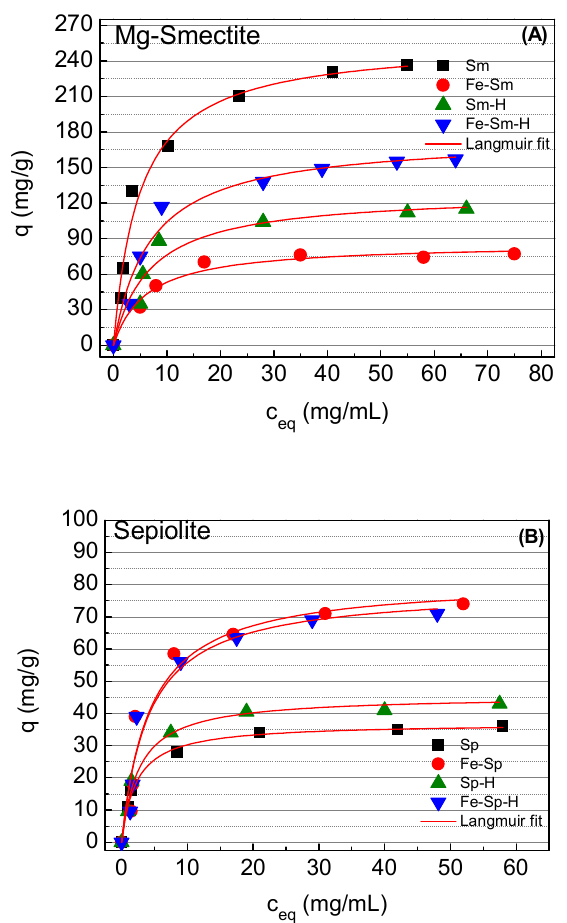
Figure 9 . Experimental adsorption isotherms of methylene blue adsorption in Sm ( A ) and Sp ( B ), and in the obtained materials.